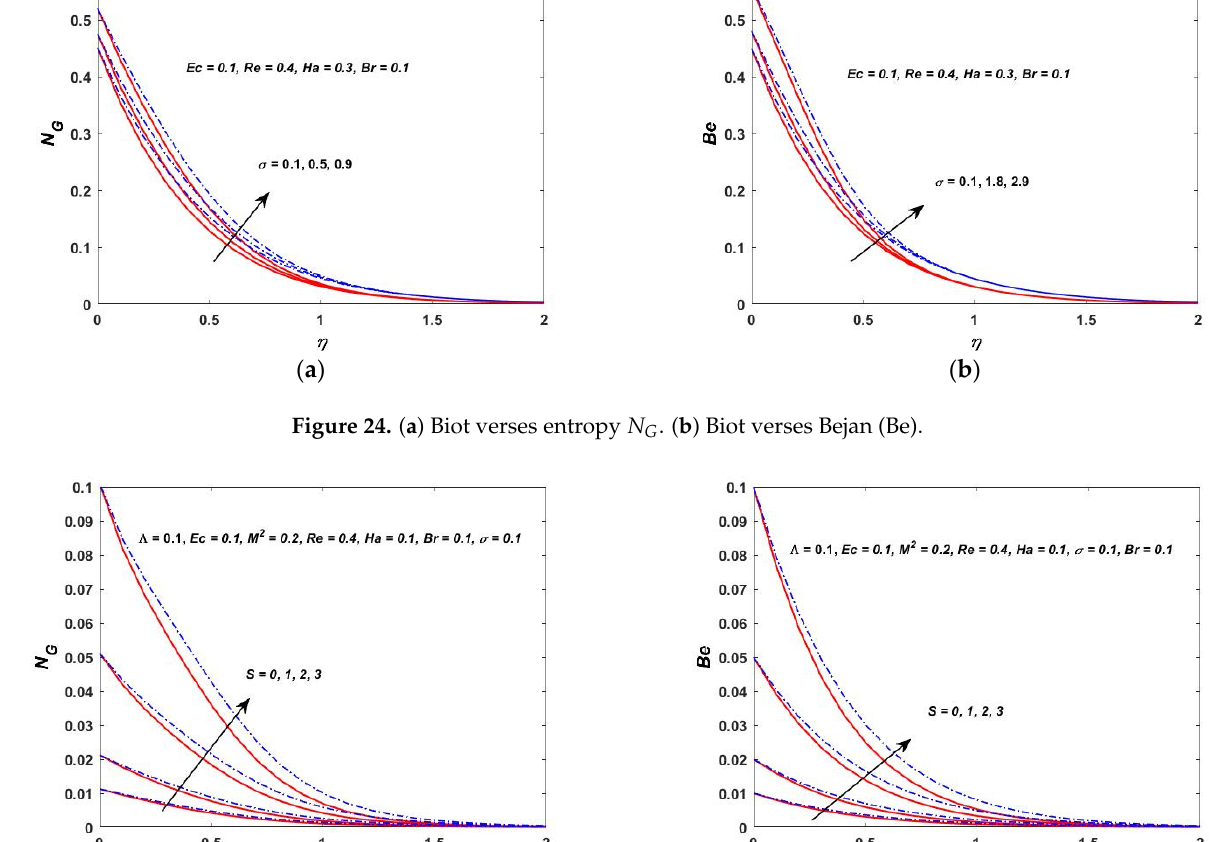
Figure 23. ( a ) Brickman verses entropy 𝑁 (cid:3008) . ( b ) Brickman verses Bejan (Be).